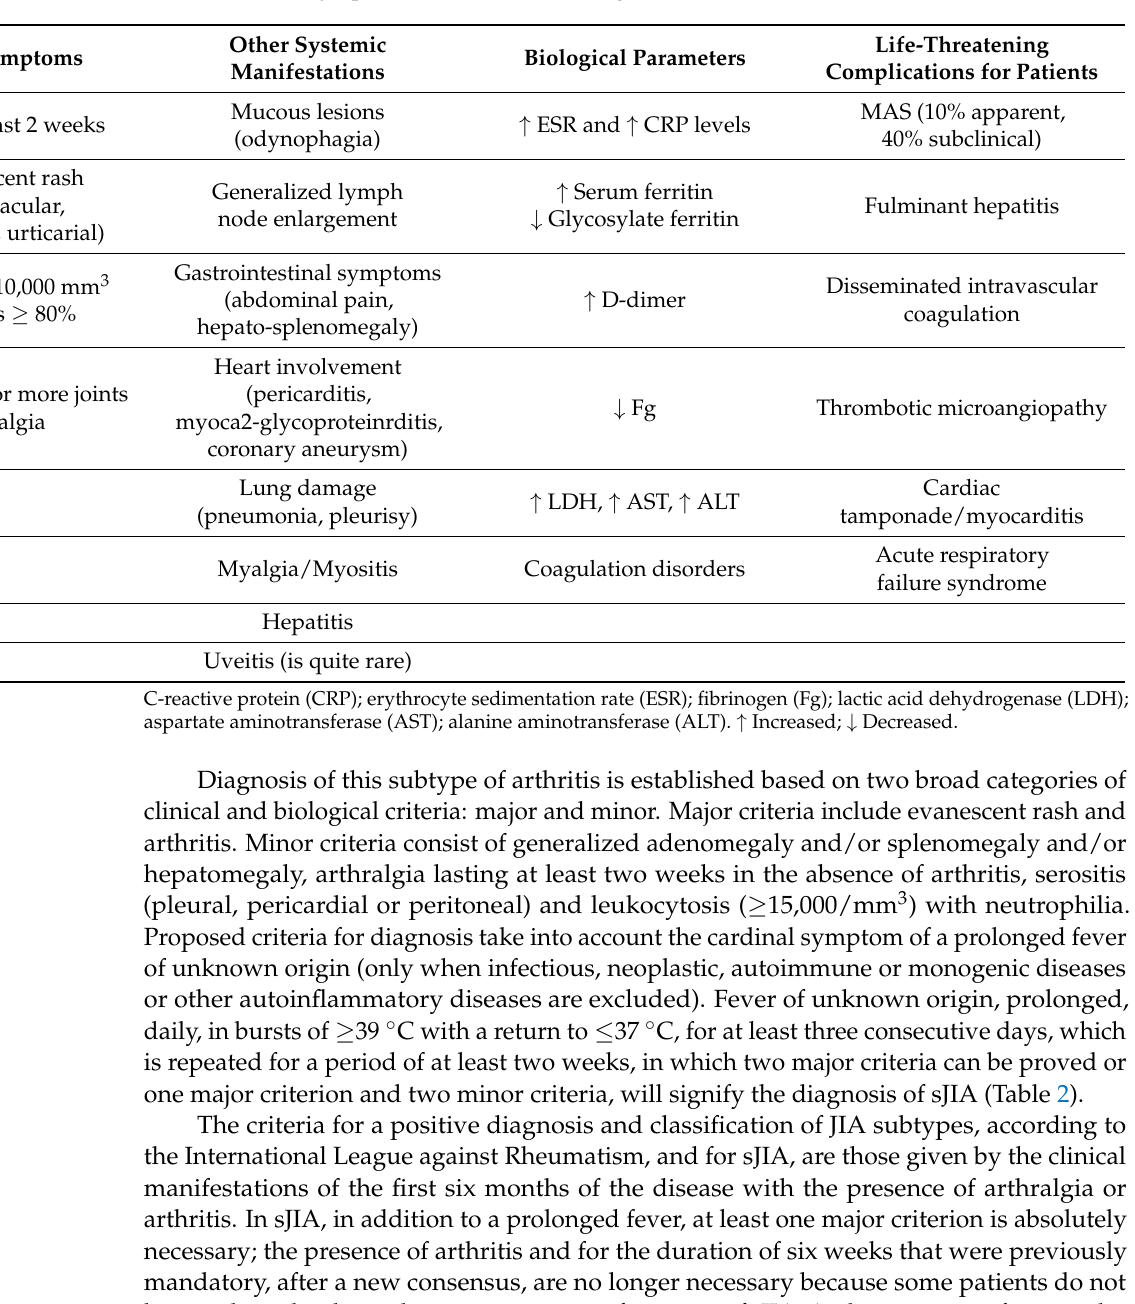
Table 1. Clinical symptoms, biomarkers and targets for